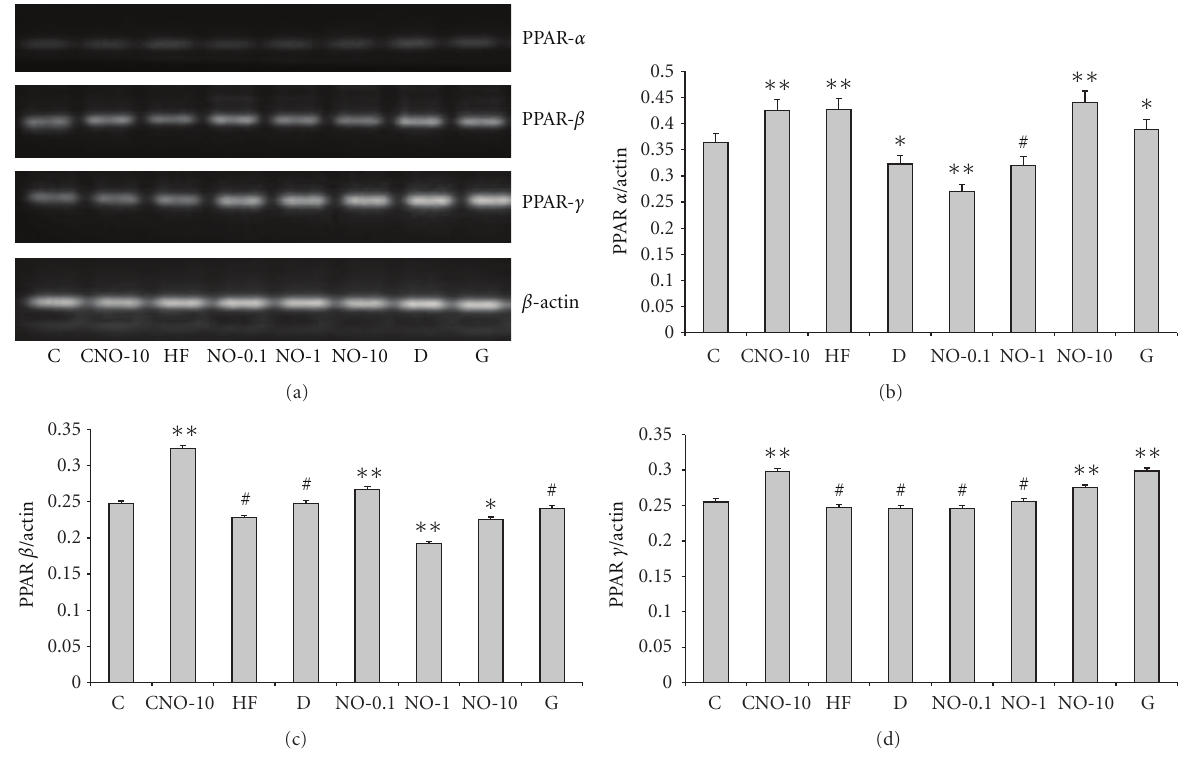
Figure 1: (a) PPAR- α , - β , - γ mRNA expressions in rat liver tissue. (b) The ratio of PPAR- α to β -actin mRNA expressions in liver tissue. (statistics are given as groups compared to control, ∗ P < 0 . 05, ∗∗ P < 0 . 001, # P > 0 . 05). (c) The ratio of PPAR- β to β -actin mRNA expressions in liver tissue. (statistics are given as groups compared to control, ∗ P < 0 . 05, ∗∗ P < 0 . 001, # P > 0 . 05) (d) The ratio of PPAR- γ to β -actin mRNA expressions in liver tissue. (Statistics are given as groups compared to control, ∗ P < 0 . 05, ∗∗ P < 0 . 001, # P > 0 . 05) C, healthy control, normal diet; CNO-10, healthy control, normal diet, and NO distillate at a dose of 375 μ g/0.5 mL of distilled water/d; HF, healthy control high fat diet; NO-0.1, type 2 diabetic, high fat diet, and NO distillate at a dose of 3.75 μ g/0.5 mL of distilled water/d; NO-1, type 2 diabetic, high fat diet, and NO distillate at a dose of 37.5 μ g/0.5 mL of distilled water/d; NO-10, type 2 diabetic, high fat diet, and NO distillate at a dose of 375 μ g/0.5 mL of distilled water/d; D, type 2 diabetic, high fat diet; G, type 2 diabetic, high fat diet, and glibenclamide at a dose of 0.6mg/kg bw/0.5 mL of distilled